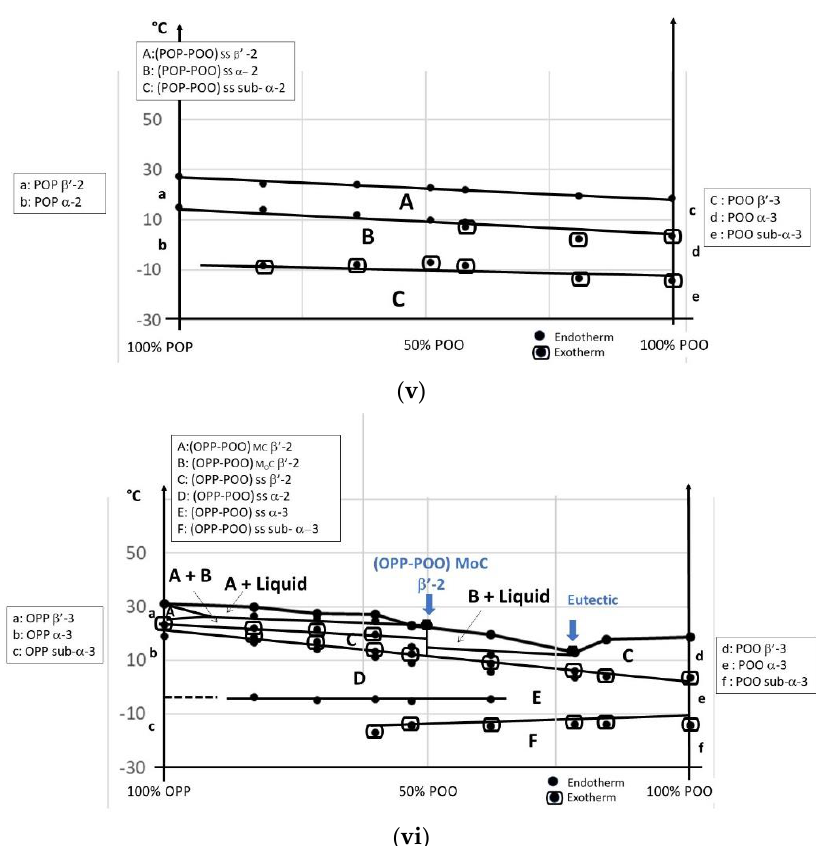
Figure 4. ( i ) (PPP-POP) phase diagram; ( ii ) (PPP-OPP) phase diagram; ( iii ) (PPP-POO) phase diagram; ( iv ) (POP-OPP) phase diagram; ( v ) (POP-POO) phase diagram and ( vi ) (OPP-POO) phase diagram, in direct mode. SS: solid solution; MC: mixed crystal; MoC: molecular compound. PPP/OPP